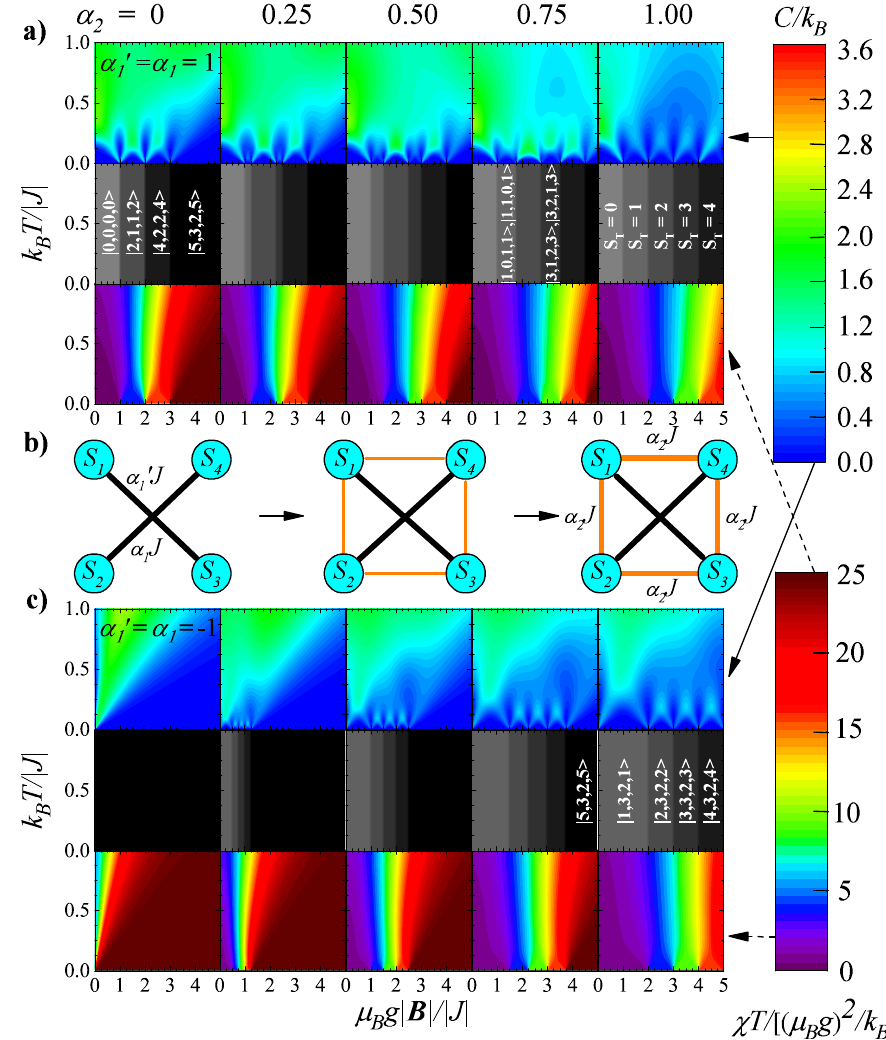
Figure 7. The figure compares the heat capacity, ground-state energy levels, and magnetic suscepti- bility times temperature as functions of k B T / | J | and µ B g | B | / | J | for the mixed valence ( S 1 = 3/2 and S 2 = 1) system. ( a ) The data for C (top), ground-state energy (GSE) (middle), and χ ∗ T (bottom) for = α = 1, while α the case of α (cid:48) 2 varied. ( b ) The evolution of the system evolving from the uncoupled 1 1 dimer configuration to the coupled tetramer configuration as α 2 varied from 0 to 1. ( c ) The data for = α = − 1 and varied α C (top), GSE (middle), and χ ∗ T (bottom) for the case of α (cid:48) 2 . The ground 1 1 states between the transitions are labelled throughout the diagrams. The first four panels (from left to right) contain the individually labelled states for those four panels. The last panel changes depending on the case. = α = 1 while α Figure 7a is for the case of α (cid:48) 2 varied from 0 to 1 in steps of 1 1